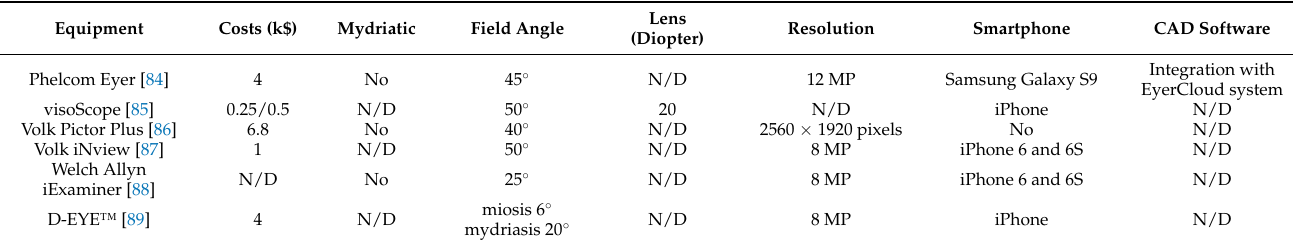
Table 3. Portable